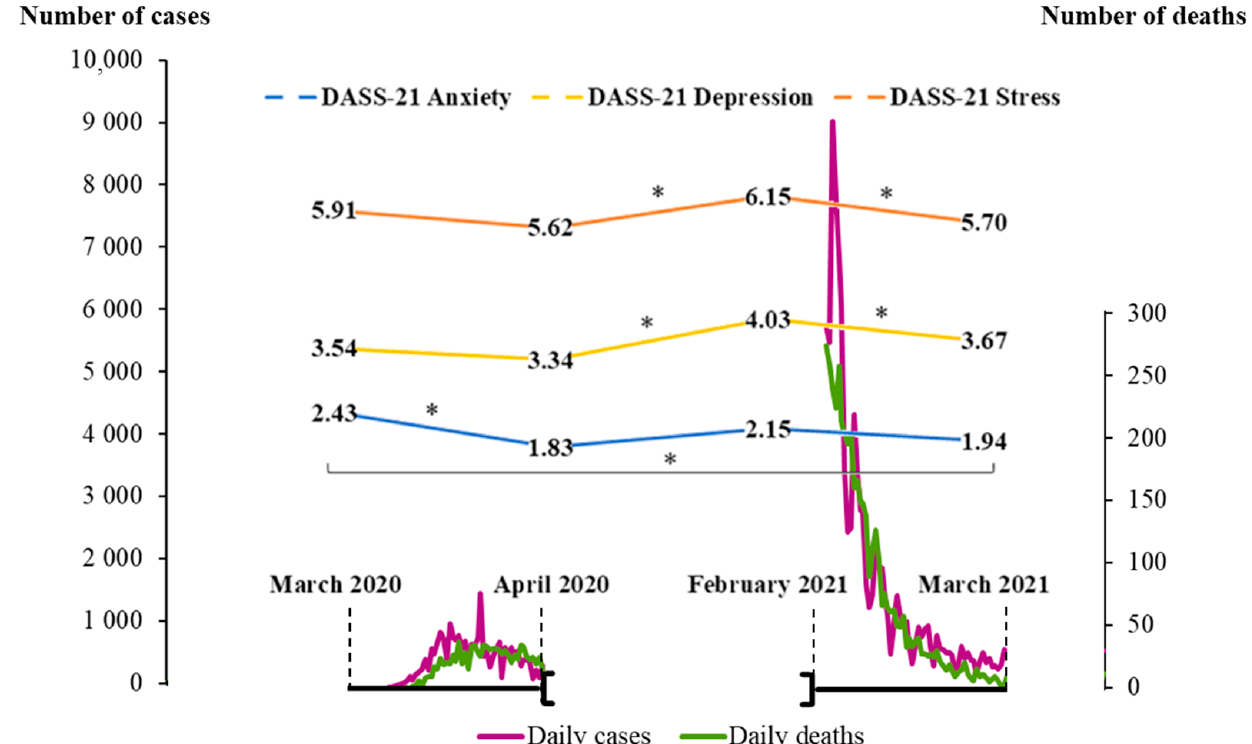
Figure 1. Evolution of the COVID-19 pandemic in Portugal: number of infected cases (magenta line), number of deaths (green line) and psychological impact (mean scores on DASS-21). * p < 0.008.